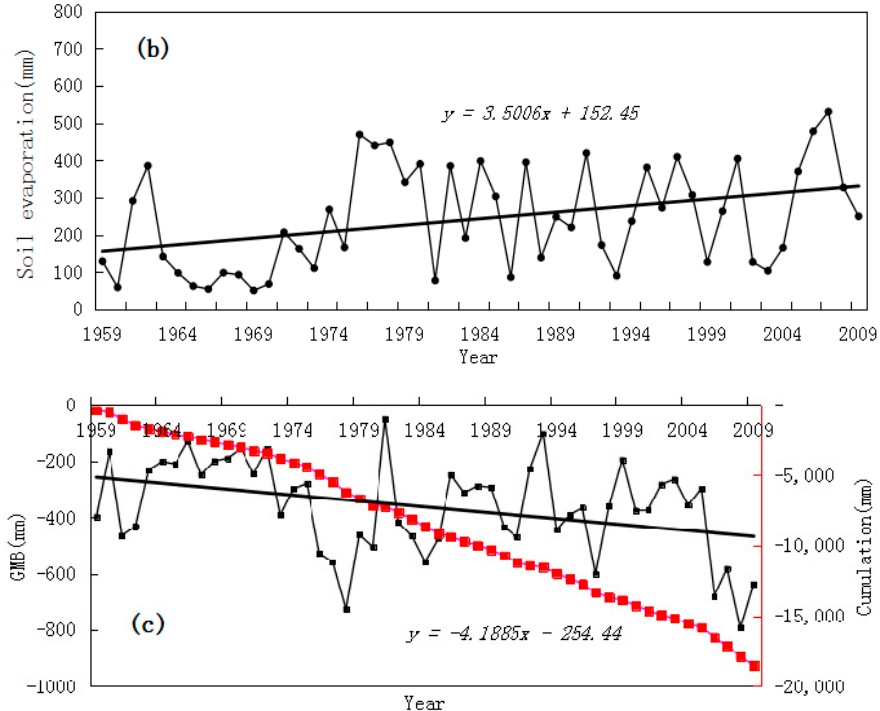
Figure 11. Simulated annual runoff depth ( a ), evaporation ( b ), and annual glacier mass balance (GMB) (black curve) and cumulation of GMB (red curve) ( c ) in the Koxkar River Basin over the period 1959–2009.